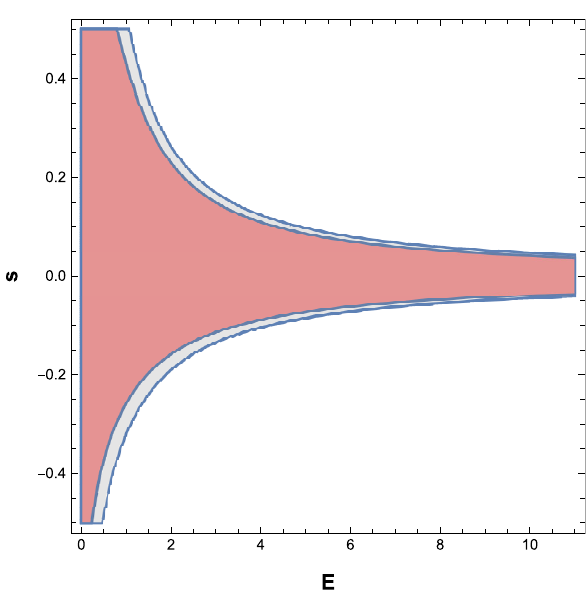
Fig. 2 The image of the function G of r and s , where d = − 0 . 28 is chosen